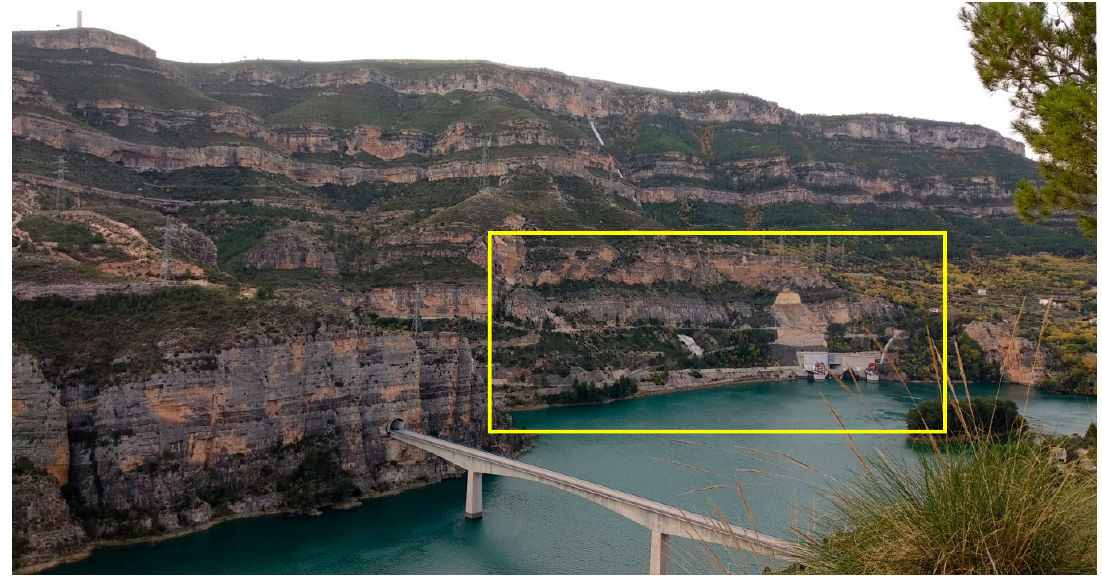
Figure 1. Perspective view of Cortes de Pallás site area.